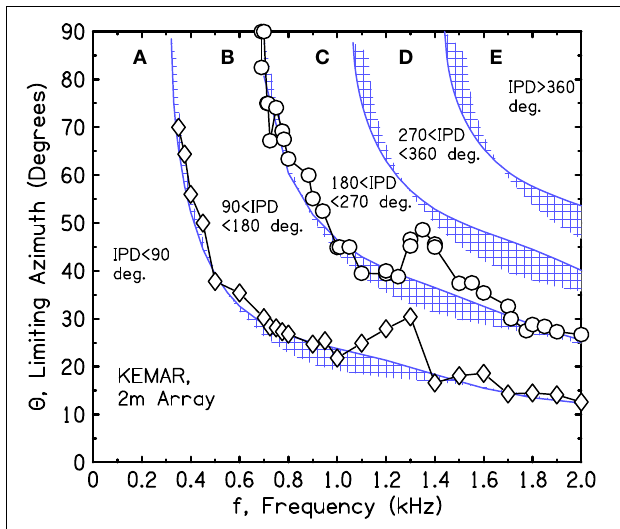
FIGURE 9 | Measured values of frequency and azimuth that lead to IPDs of 90 ◦ and 180 ◦ for a KEMAR manikin. Values were interpolated from measurements using a source array in one quadrant to the right of the manikin.